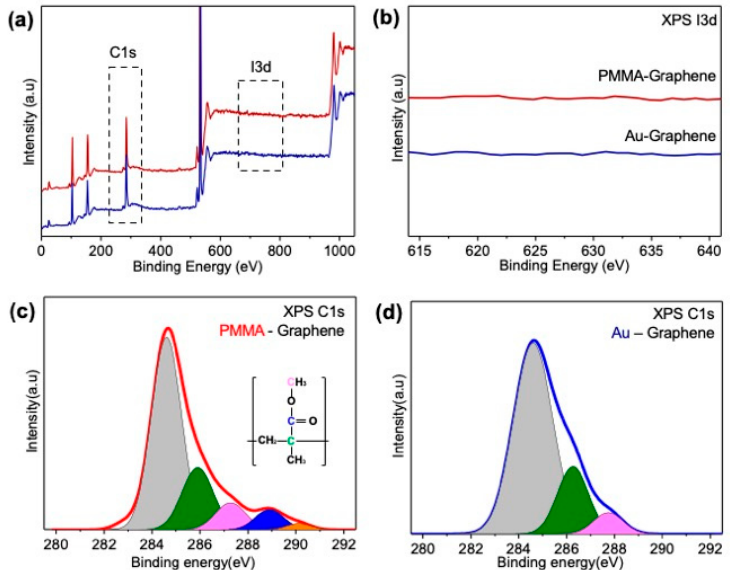
Figure 2. ( a ) XPS data for graphene transferred using PMMA and graphene transferred using Au film. ( b ) The I 3d region in ( a ). ( c ) C 1s region in graphene transferred using PMMA. ( d ) C 1s region in graphene transferred graphene using Au film.